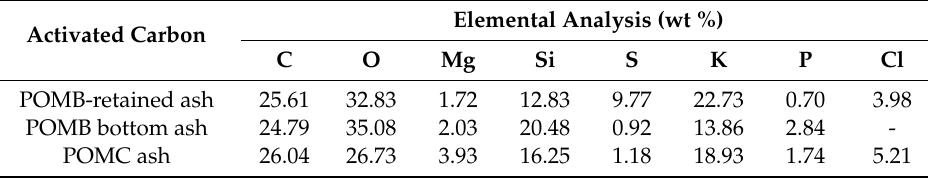
Table 2. Elemental analysis of POMB-retained ash, POMB bottom ash, and POMC ash.